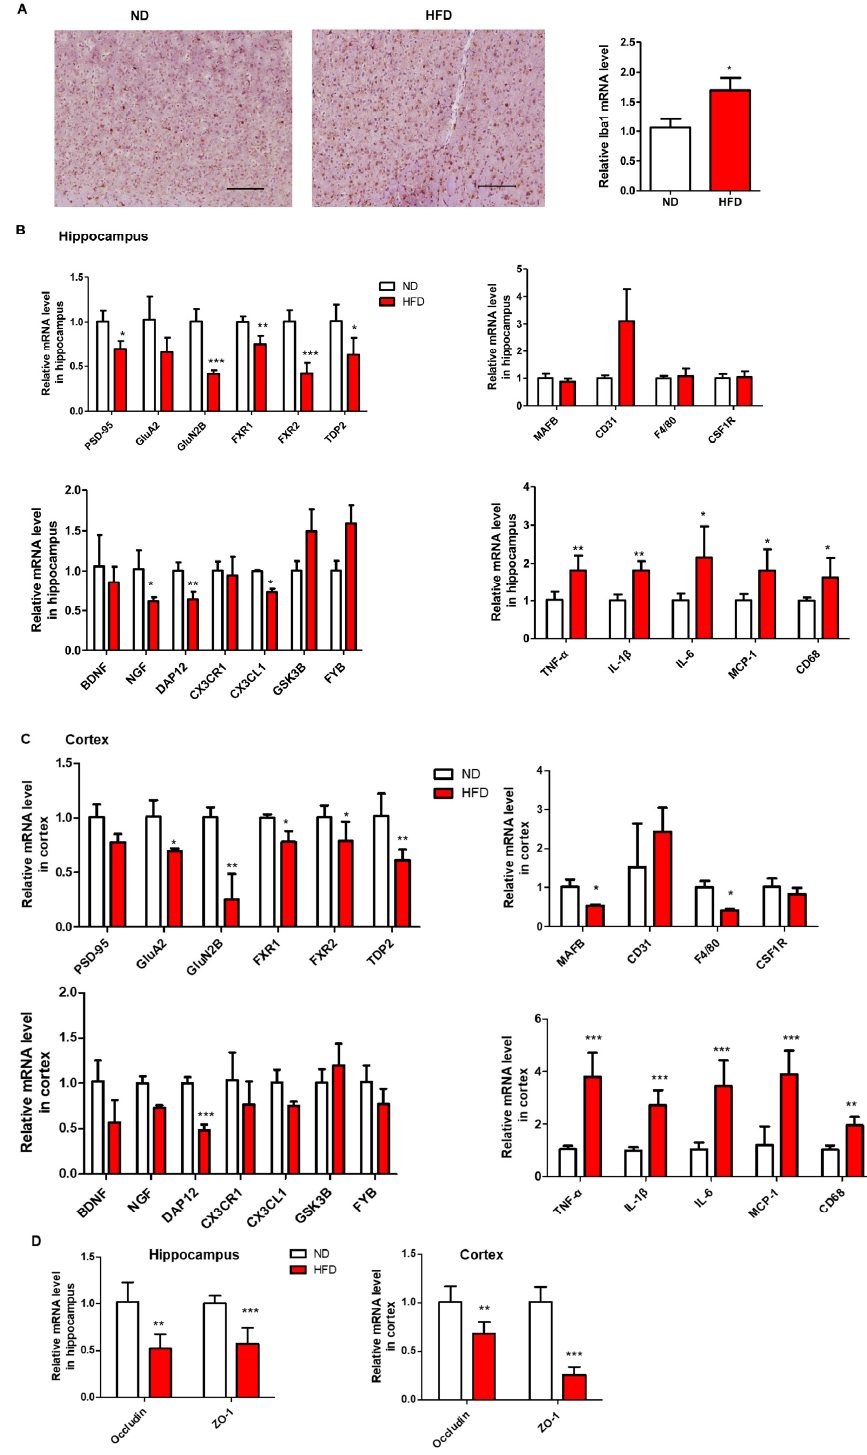
Figure 9. Effect of long-term HFD consumption on the expression of markers involved in microglia function and synapse damage in hippocampus and prefrontal cortex. Representative images of IHC of Iba-1 protein in prefrontal cortex and relative mRNA level of Iba-1 ( A ). The mRNA levels of synapse-, microglia maturation-, microglia function- and inflammation- related genes in the hippocampus ( B ) and in the prefrontal cortex ( C ). The mRNA levels of tight junction proteins, ZO-1 and Occludin, in hippocampus and prefrontal cortex ( D ). Values are shown as the mean ± SEM. t -test was performed. * p < 0.05; ** p < 0.01; *** p < 0.001. Bar: 100 µ